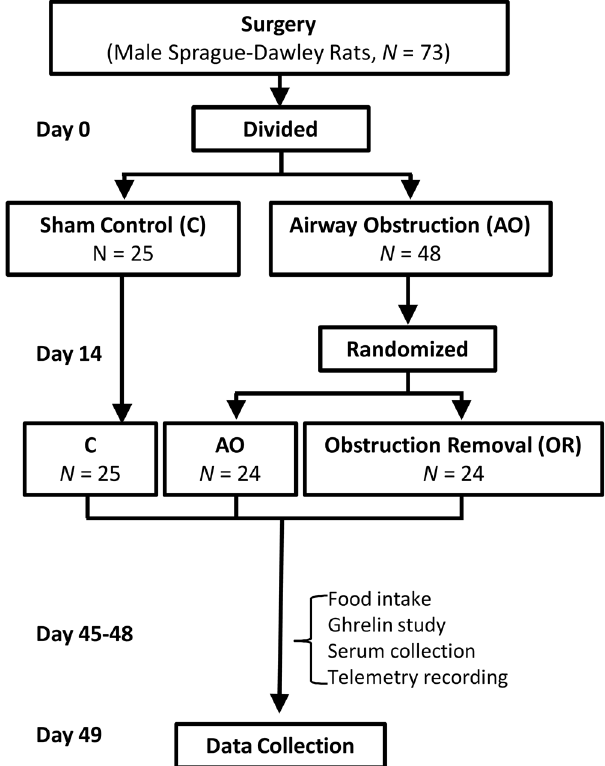
Figure 1. Flow diagram of study groups and times data was